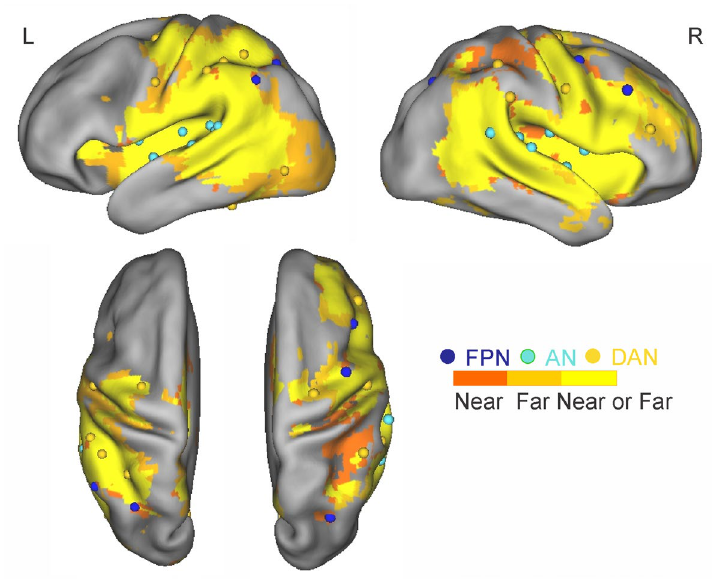
Figure 2. Voxels showing significant group-wise fMRI activation during near (dark orange), far (light orange) or during both space conditions (yellow) together with the representation of the ROIs selected from Baldassarre et al. 84 superimposed over an inflated cortical representation. Different networks are color coded (blue: fronto- parietal network (FPN); cyan: auditory network (AN); orange: dorsal attention network